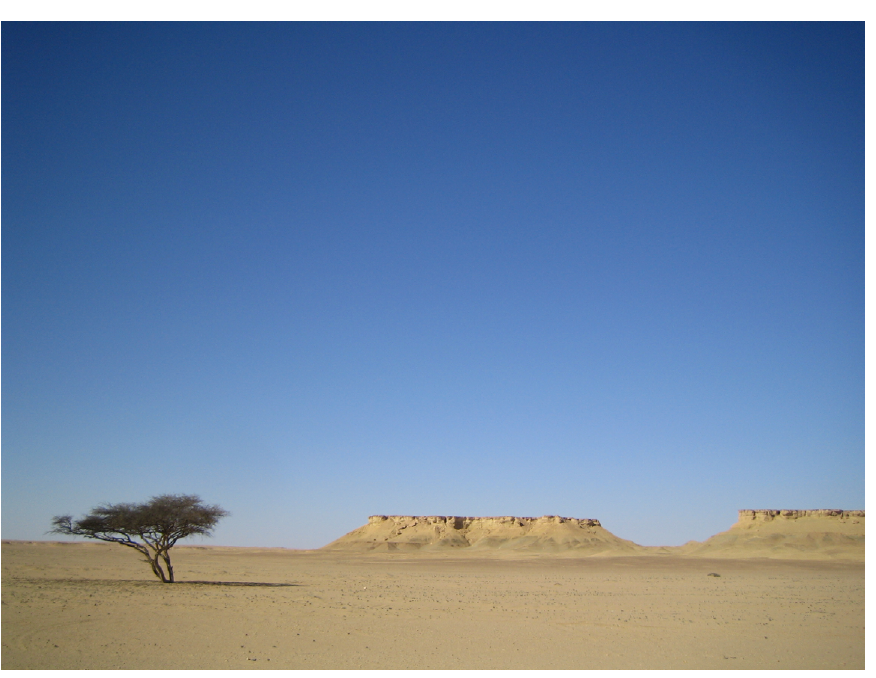
Fig. 15. Orientation along the routes with natural markers: Acacia tree at the height of the Oasis Qara (cf. Fig. 7). (Anna-Katha- rina Rieger).